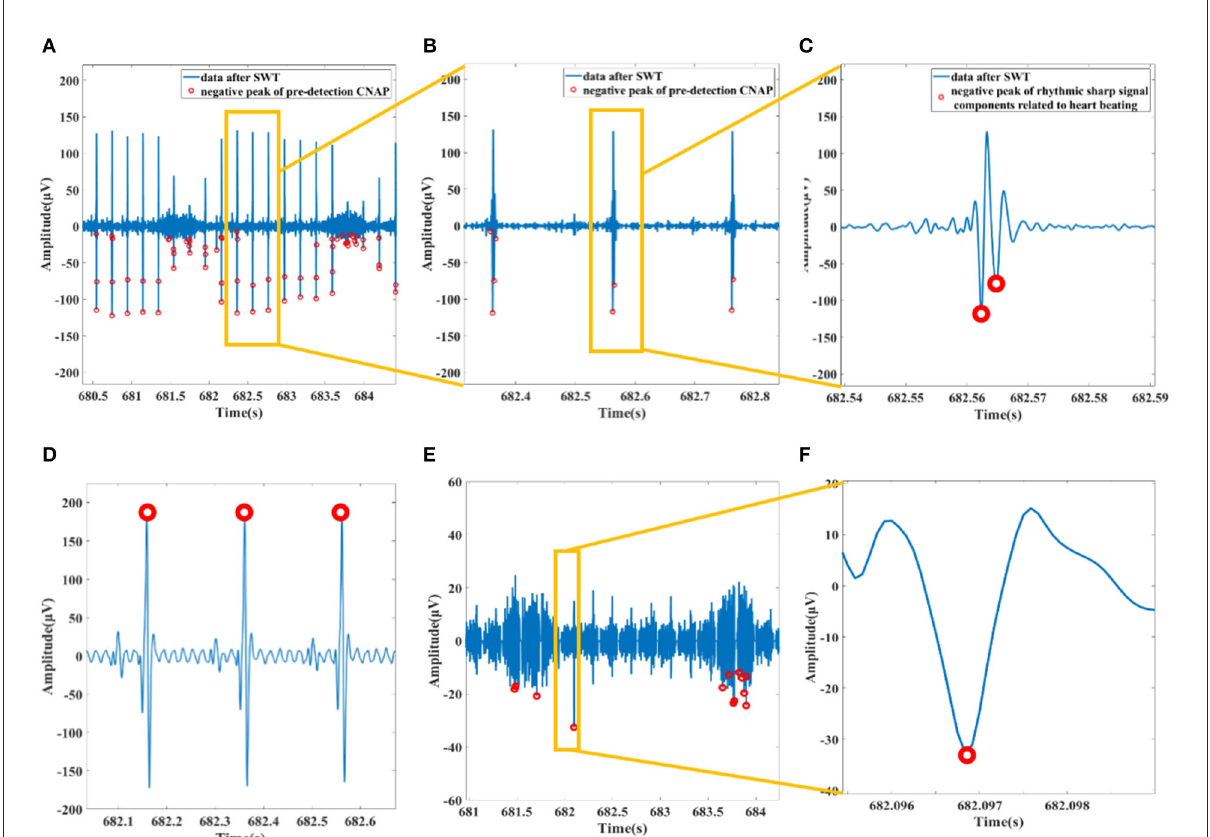
FIGURE4 (A) Data after SWT and pre-detection CNAP. (B) Filtered ECG mistakenly detected as CNAP. (C) An example of a rhythmic sharp signal from heart beating. (D) Preprocessed data passing through a 160 Hz lowpass filter and the R wave of ECG detected. (E) Data with ECG and related